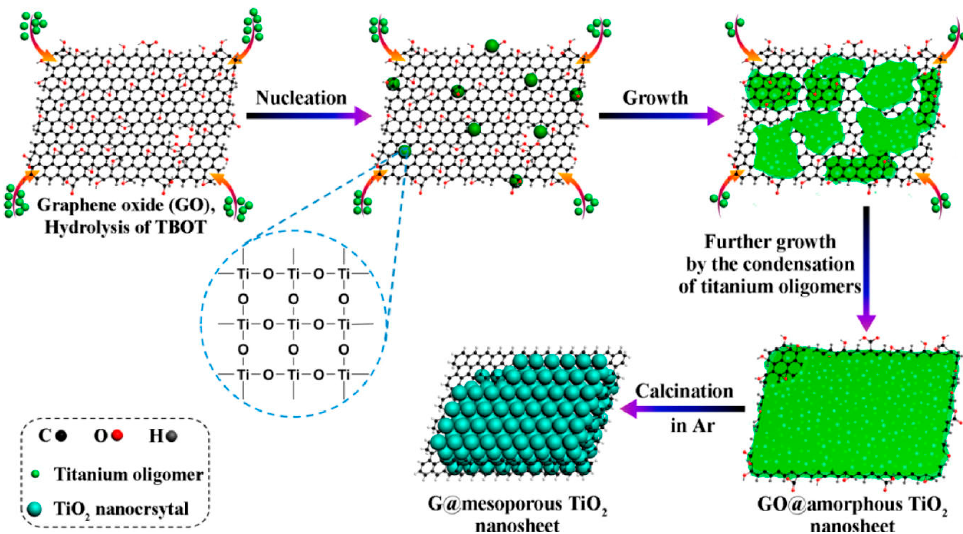
Figure 2. Schematic formation process of the mesoporous TiO 2 /graphene/mesoporous TiO 2 sandwich-like nanosheets. Reprinted with permission from [22]. Copyright 2018, American Chemical Society.